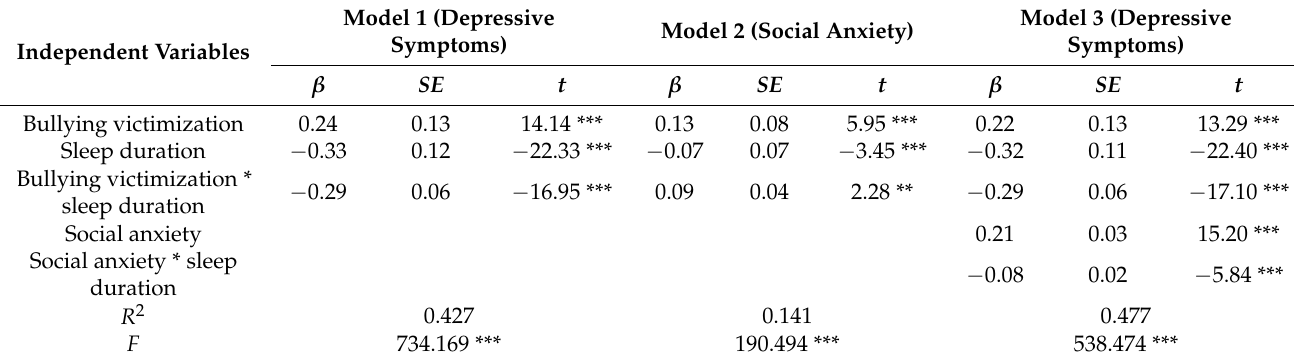
Table 4. Testing the moderated mediation effect of bullying victimization on depressive